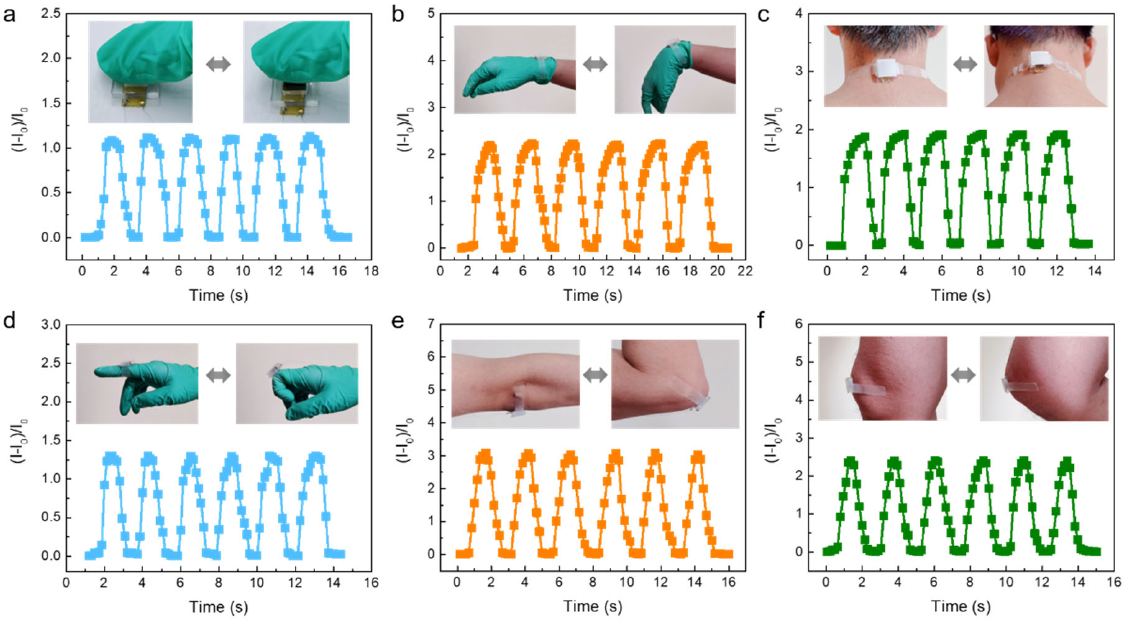
Figure 6. Monitoring human motion using HMFPS; ( a ) Finger pressing, ( b ) wrist bending, ( c ) nodding, ( d ) finger movement, ( e ) arm bending, and ( f ) knee bending.